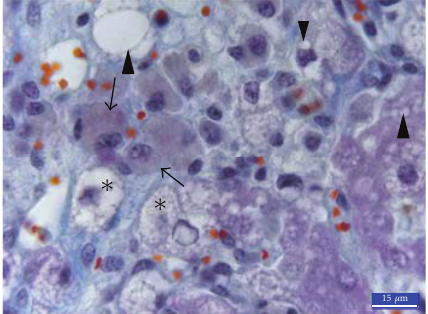
Figure 2: Liver histology from an animal contaminated with AF (250 μ g/day of total AF, AF group). Macrophages containing ceroid pigment (arrows), severe vacuolar degeneration in hepatocytes (arrowheads), and hydropic degeneration (stars) in the AF group, 3rd region, trichrome staining.